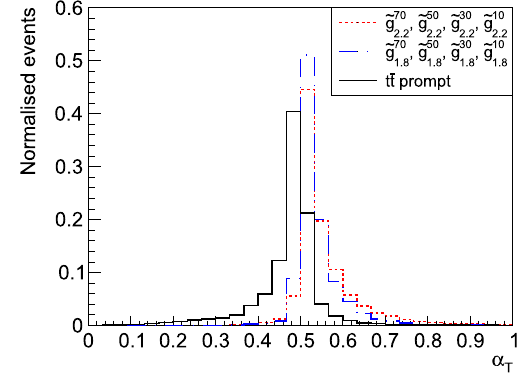
Fig. 68 α T distributions in the gluino ˜ g case